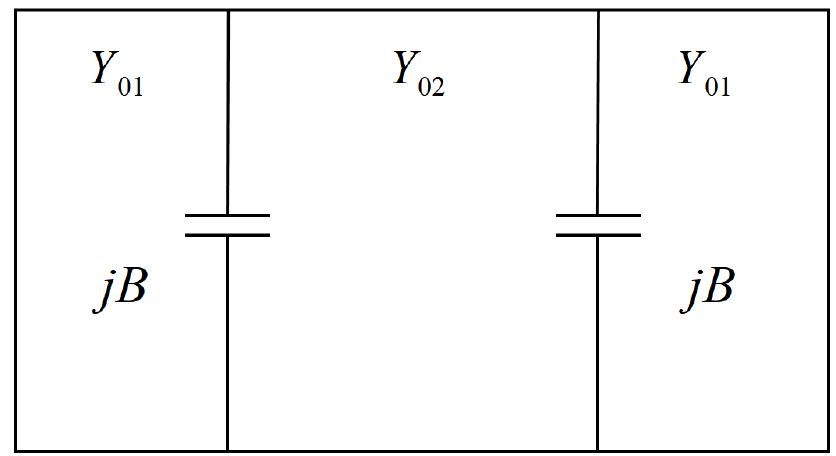
Figure 2. The equivalent circuit of the double-ridged waveguide.